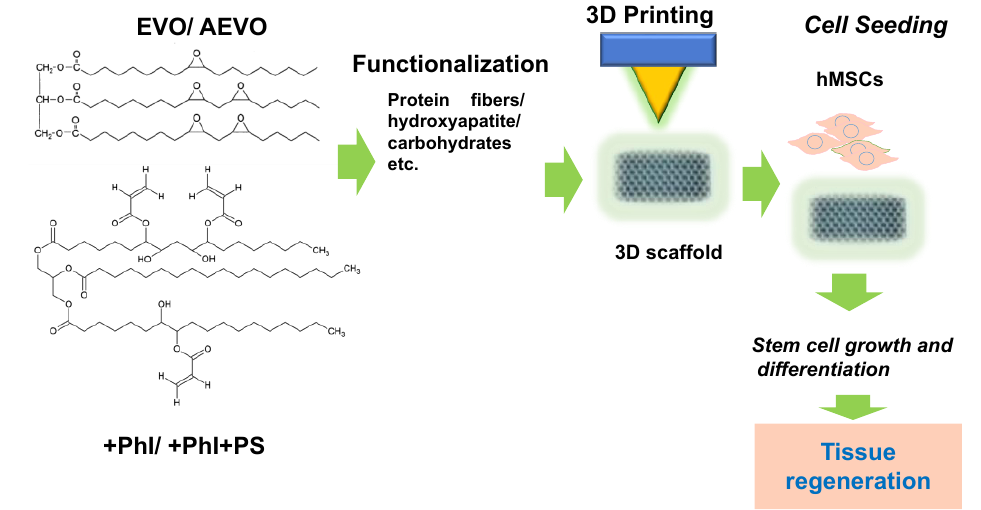
Figure 8. Schematic representation of the vegetable oil-based scaffolds for stem cell growth.